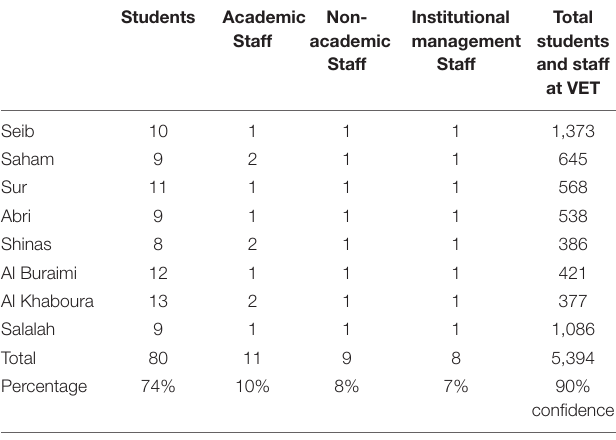
TABLE 1 | Distribution of study respondents by occupation.